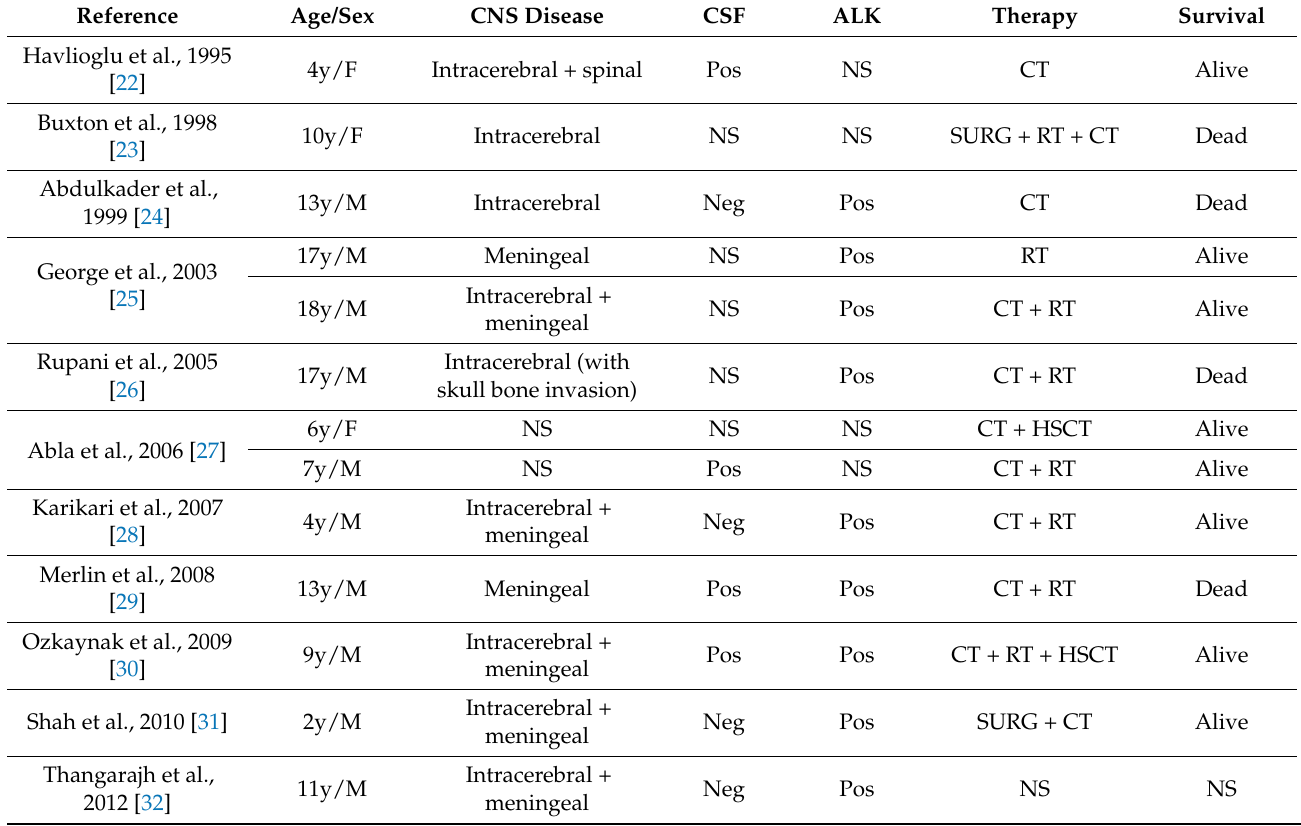
Table 4. Characteristics of reported pediatric patients with primary CNS